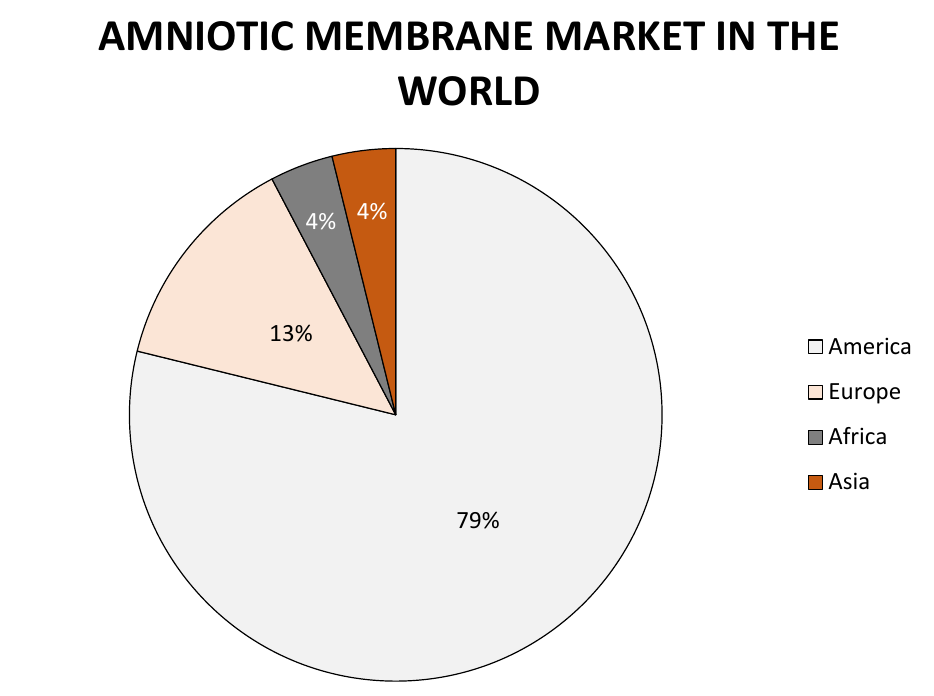
Figure 8. Representation of world market of amniotic membrane.